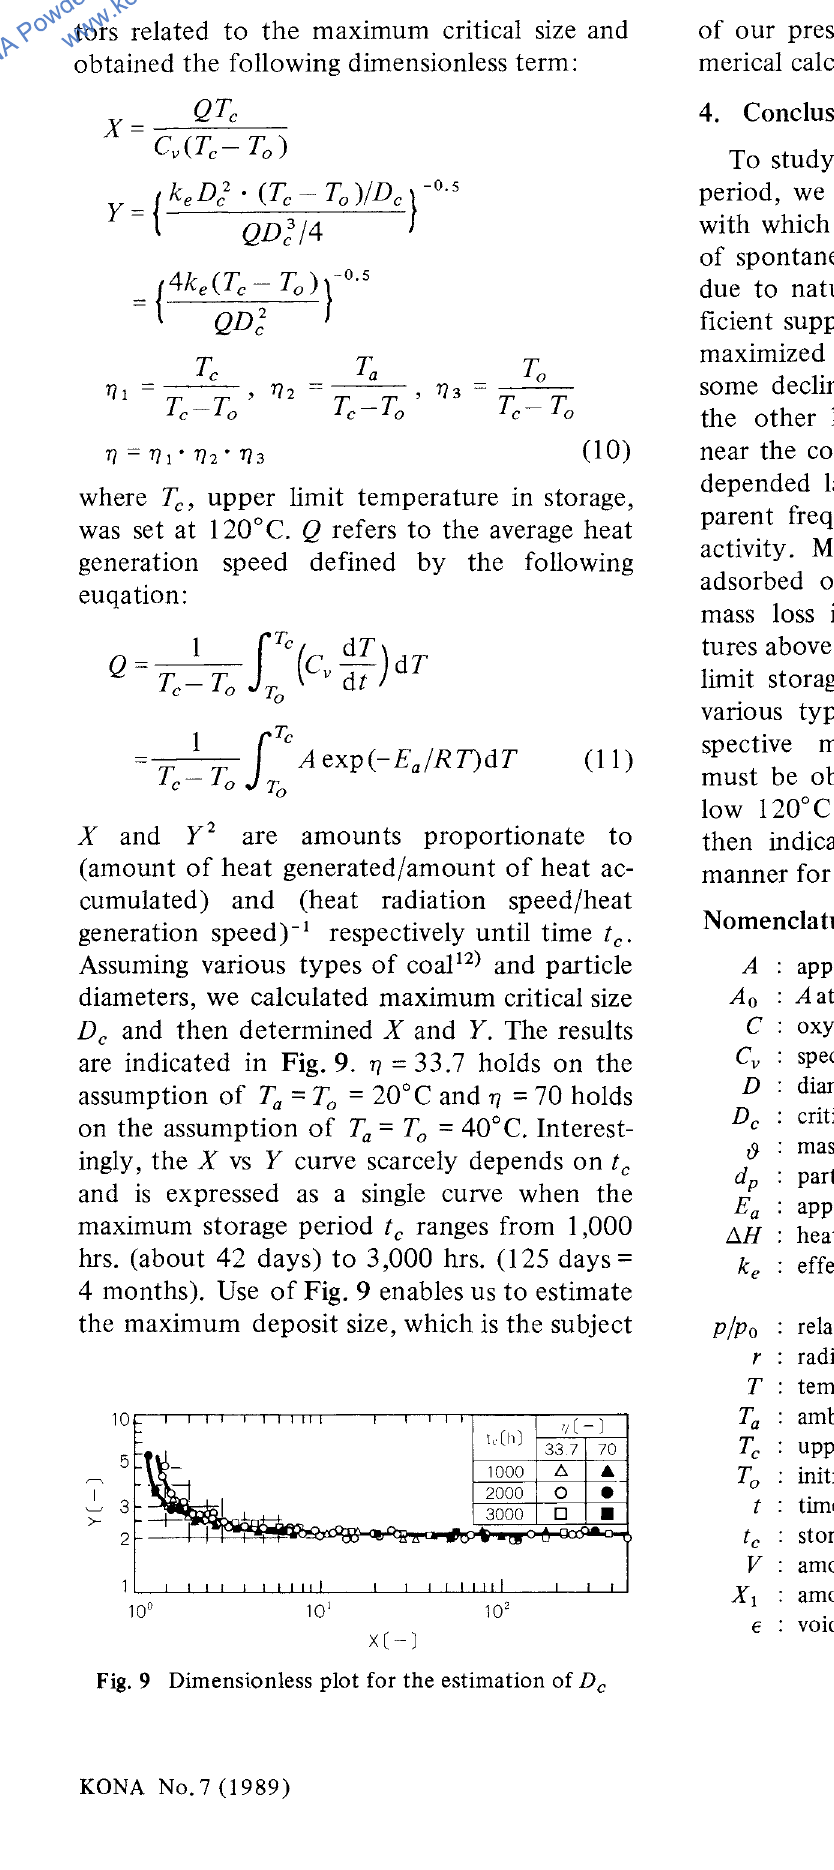
Fig. 9 Dimensionless plot for the estimation of De